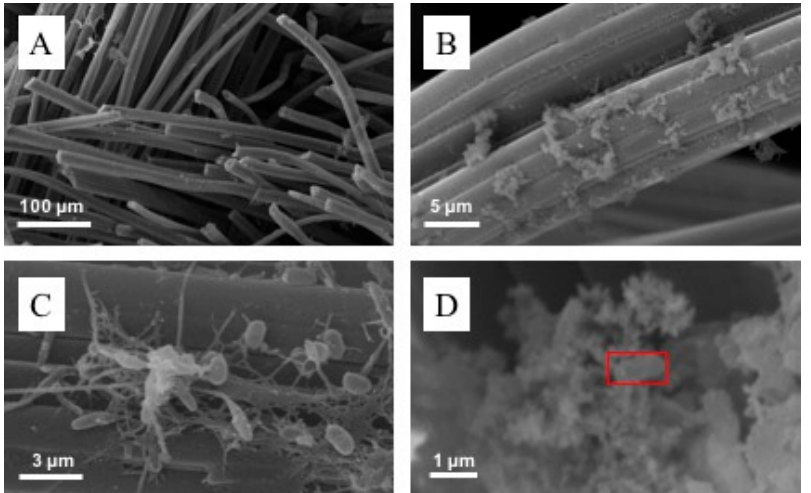
Figure 5. Scanning electron micrographs of carbon felt biocathodes. ( A ) Electrode fibers (magnification 500X. ( B ) Early biofilm formation over fibers (magnification 5000X). ( C ) Microorganisms and extracellular polymeric substances-like structures formed over electrodes (magnification 5000X). ( D ) Mineral precipitates formed over the biofilm. The red square represents the surface area analyzed by EDS.